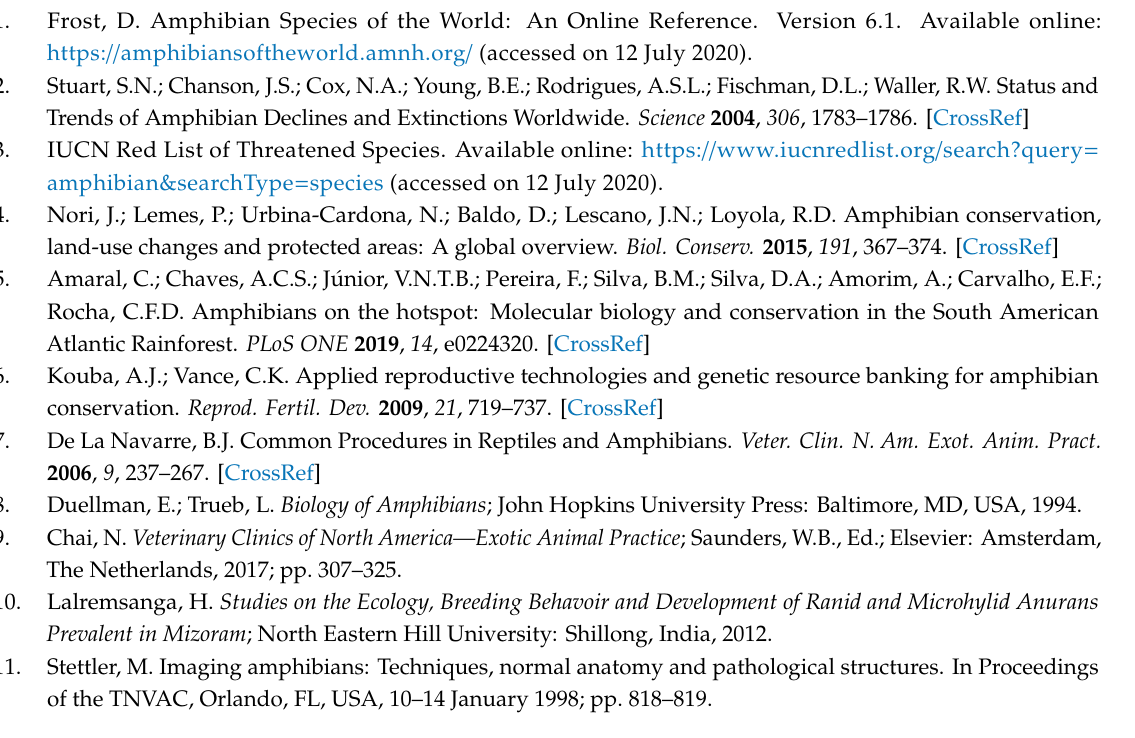
s1, Figure S1: MRI identification of structures contained in the coelomic cavity, Graph S1: MRI-Volumetric quantification of testes and kidneys, Figure S2: Additional sex-gender system structures identified by MRI, Figure S3: MRI identification of reproductive system